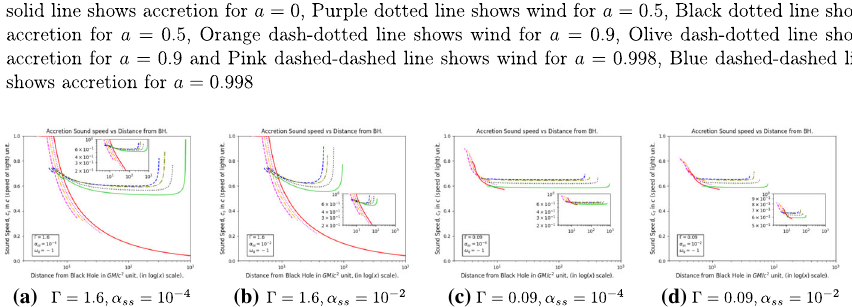
Fig. 2 Curves for sound speed vs radial distance from the BH. 2.1 Images for λ c = 2 . 7 ,ω q = 1 / 3 , A q = 0 . 01. Red solid line shows wind for a = 0,Greensolidlineshowsaccretionfor a = 0,Purpledottedline shows wind for a = 0 . 5, Black dotted line shows accretion for a = 0 . 5, Orange dash-dotted line shows wind for a = 0 . 9, Olive dash-dotted line shows accretion for a = 0 . 9 and Pink dashed-dashed line shows wind for a = 0 . 998, Blue dashed-dashed line shows accretion for a = 0 . 998. 2.2 Imagesfor λ c = 2 . 7 ,ω q = 0 , A q = 0 . 01.Redsolidlineshowswind for a = 0,Greensolidlineshowsaccretionfor a = 0,Purpledottedline shows wind for a = 0 . 5, Black dotted line shows accretion for a = 0 . 5, Orange dash-dotted line shows wind for a = 0 . 9, Olive dash-dotted line shows accretion for a = 0 . 9 and Pink dashed-dashed line shows wind for a = 0 . 998, Blue dashed-dashed line shows accretion for a = 0 . 998.